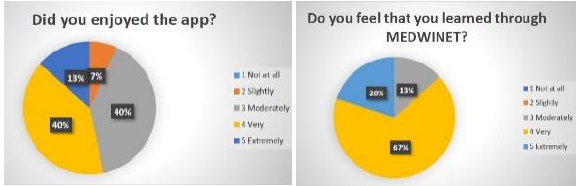
Figure 15. Pie charts presenting the entertaining and educational